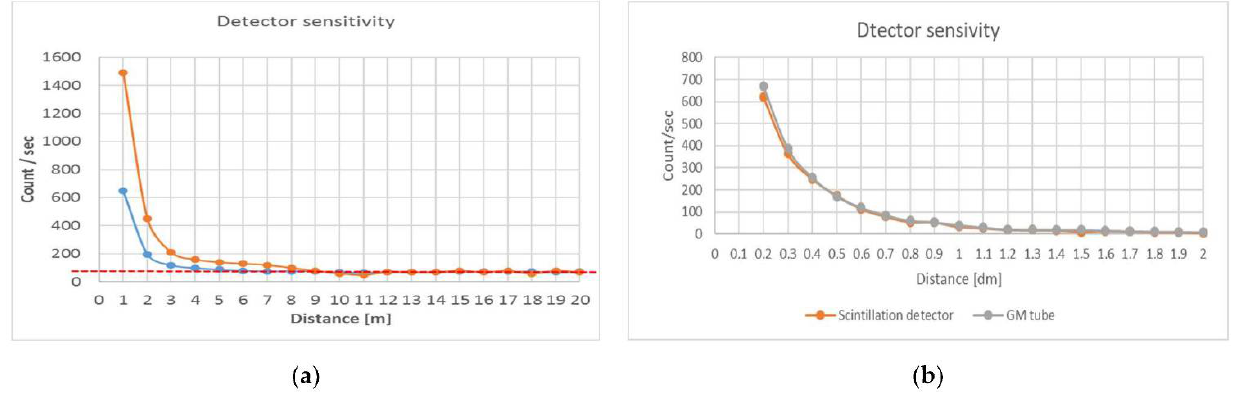
Figure 3. Static test of new detector ( a ), and old ( b ) sensitivity. The orange line whit selective energy window, blue line without selective energy window.